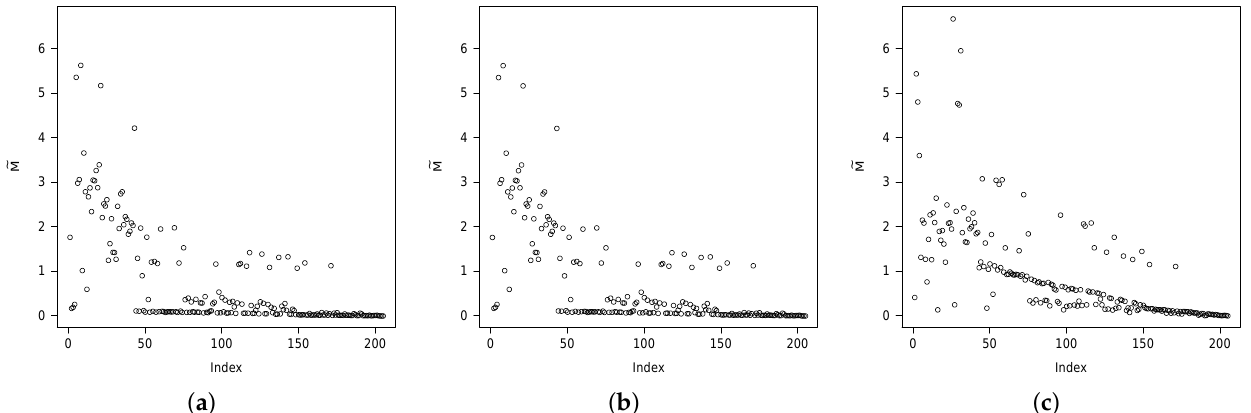
Figure 4. Estimate of the mean of the conditional distribution of M i | t i , δ i ; (cid:98) ψ in melanoma data set using ( a ) Bellcr, ( b ) Locr and ( c ) Geocr